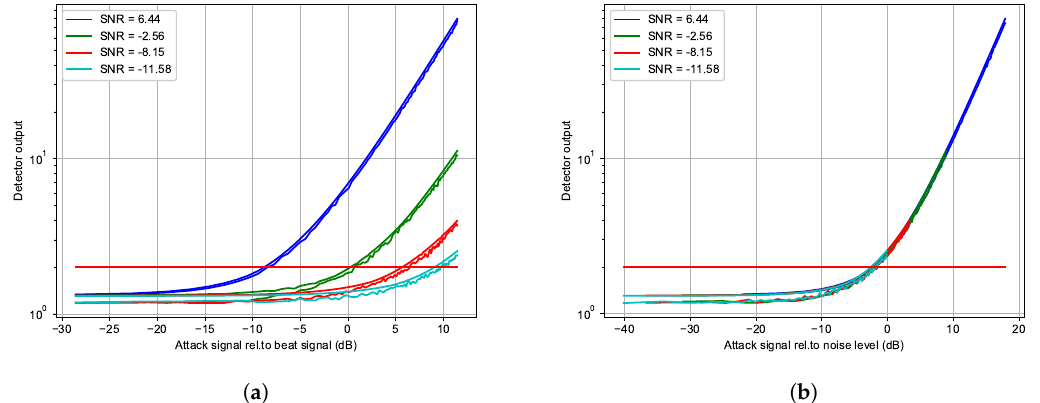
Figure 13. Test case eTX2R. The horizontal orange colored line is the detection threshold. In ( a ) with respect to the beat signal level, and in ( b ) with respect to the noise level.